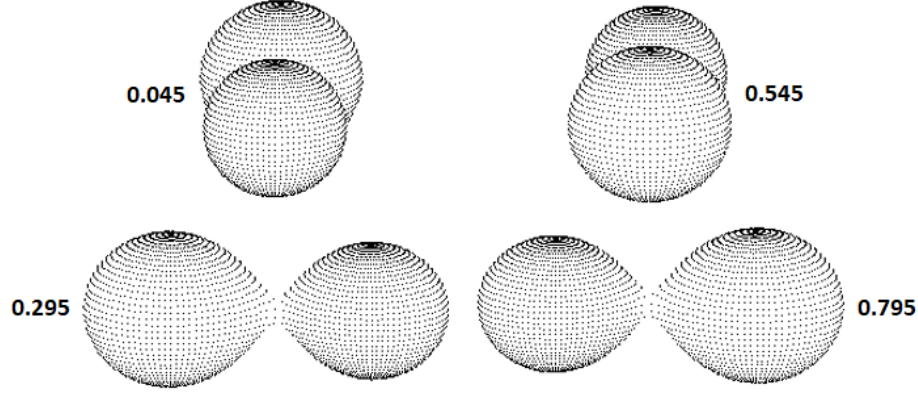
Figure 7. The 3D view of the stars.